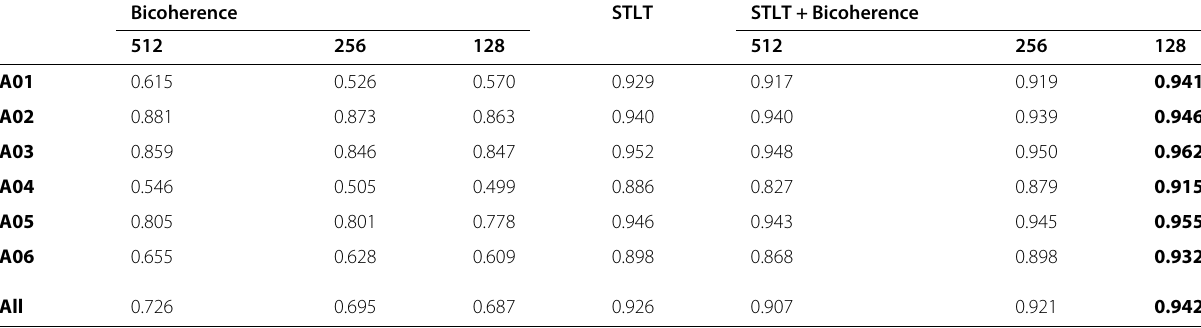
Table 2 Bona fide vs. synthetic accuracy on dataset D dev for each synthetic speech algorithm Bicoherence STLT